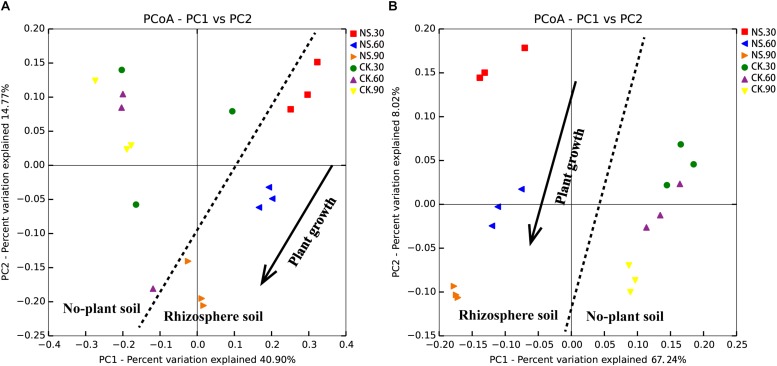
PCoA of no-plant soil and rhizosphere fungal (A) and bacterial (B) communities associated with sanqi grown for 30, 60 and 90 days, based on the Bray distance metric. NS30, NS60, and NS90 indicate rhizosphere soil from sanqi grown for 30, 60, and 90 days, respectively; CK30, CK60, and CK90 indicate no-plant soil collected at 30, 60, and 90 days, respectively.